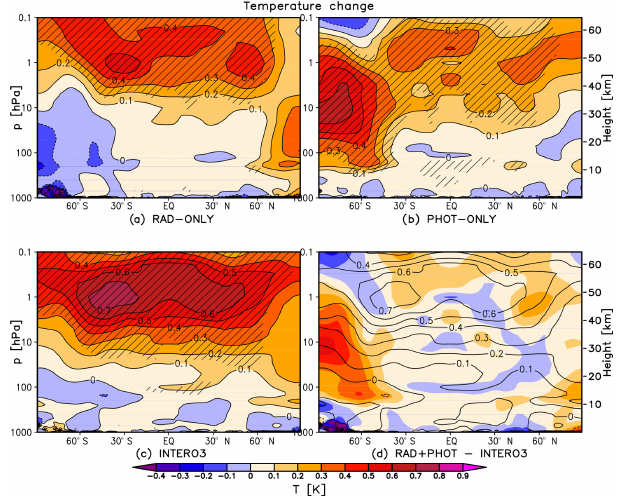
Figure 1. Yearly mean zonal mean temperature change (K) be- tween SMAX and SMIN for (a) RAD-ONLY, (b) PHOT-ONLY and (c) INTERO3. Hatching in (a) – (c) shows regions where the re- sponse is statistically significant at the 95% level (calculated using a two-tailed Student t test). Shown also (d) is the difference (shad- ing) between the sum of the single-forcing responses and INTERO3 (contours, as in c